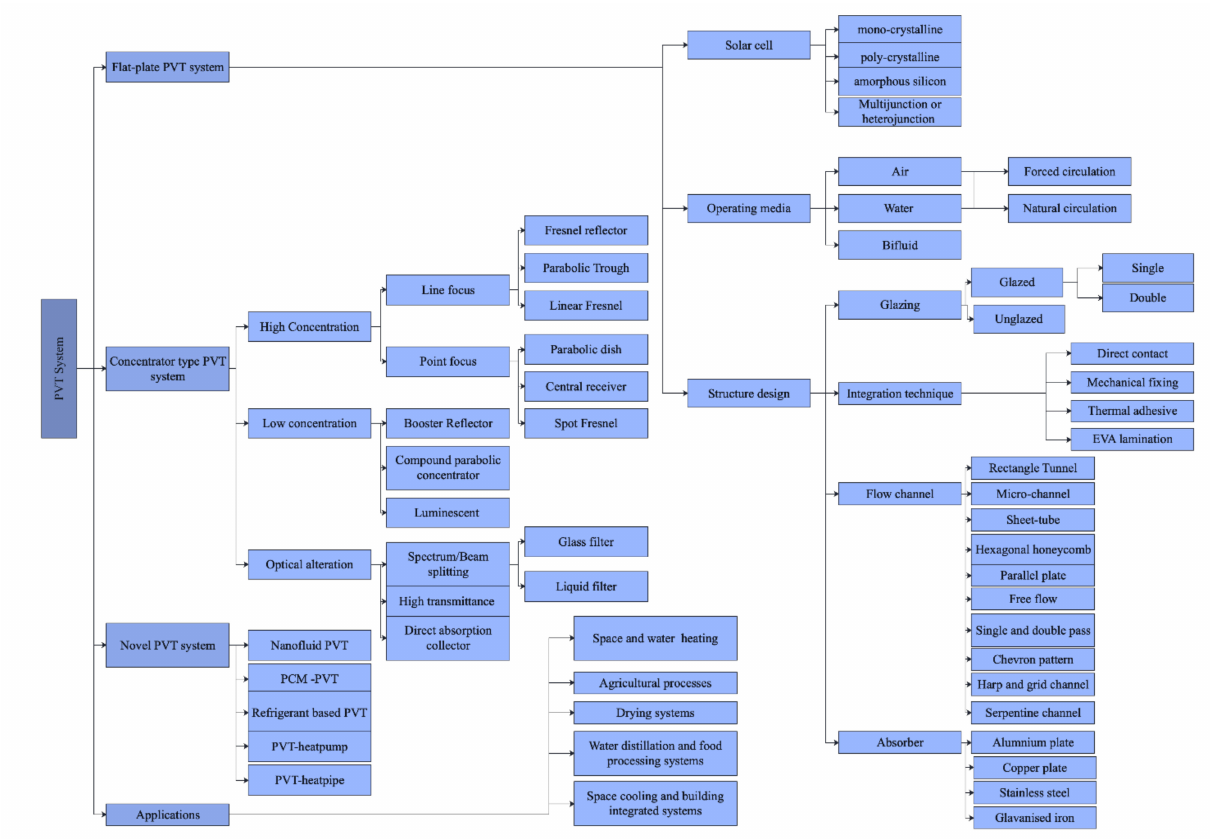
Figure 6. General classification of the PVT system (Information taken from [28,38,40,64]).